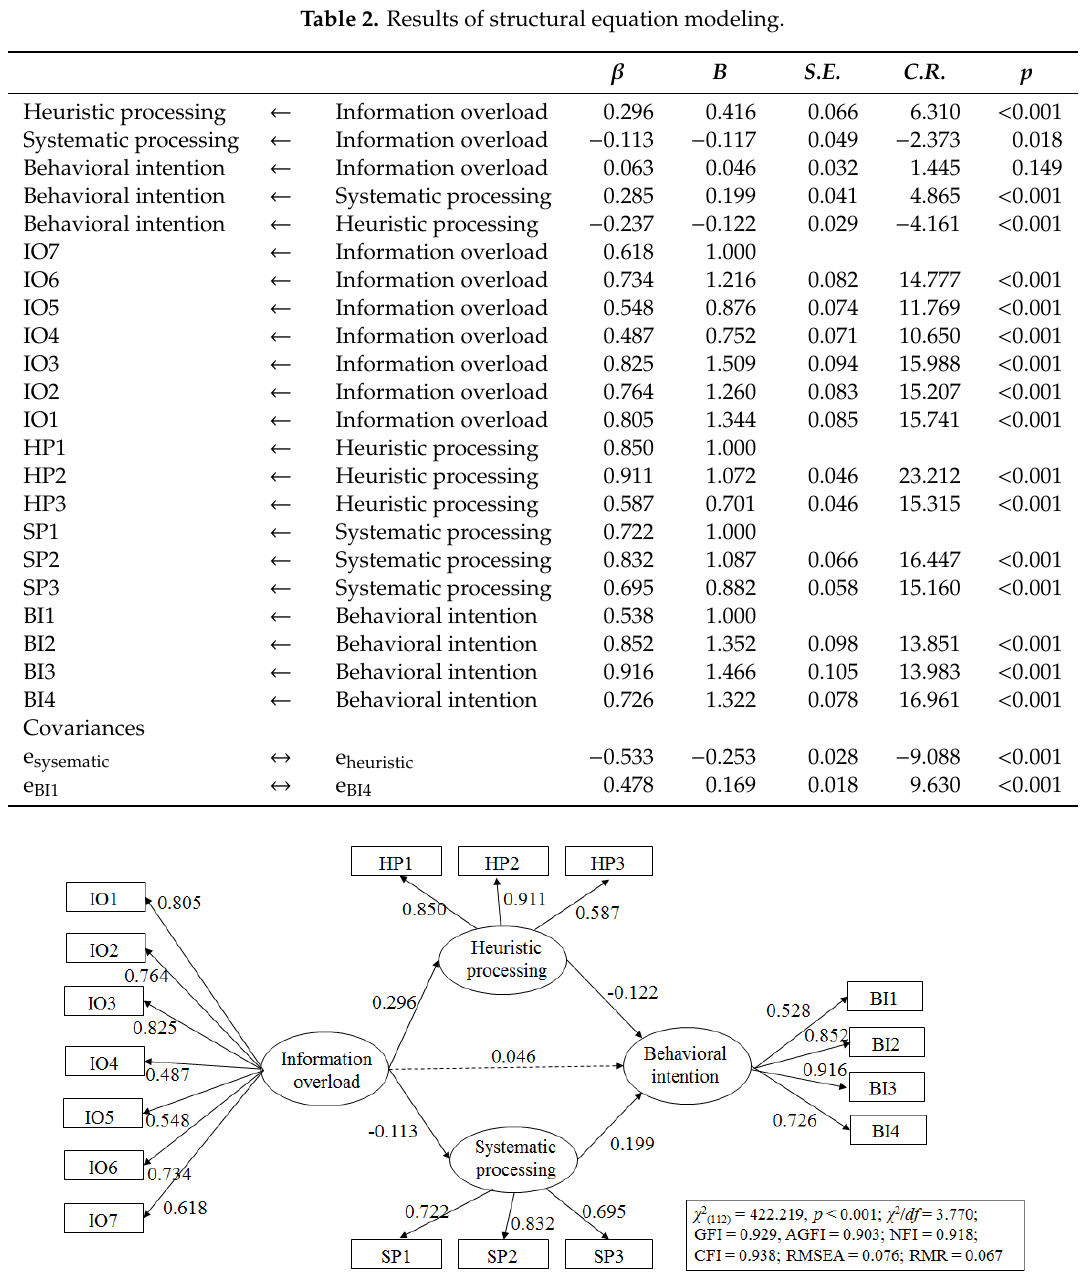
Table 2. Results of structural equation modeling.